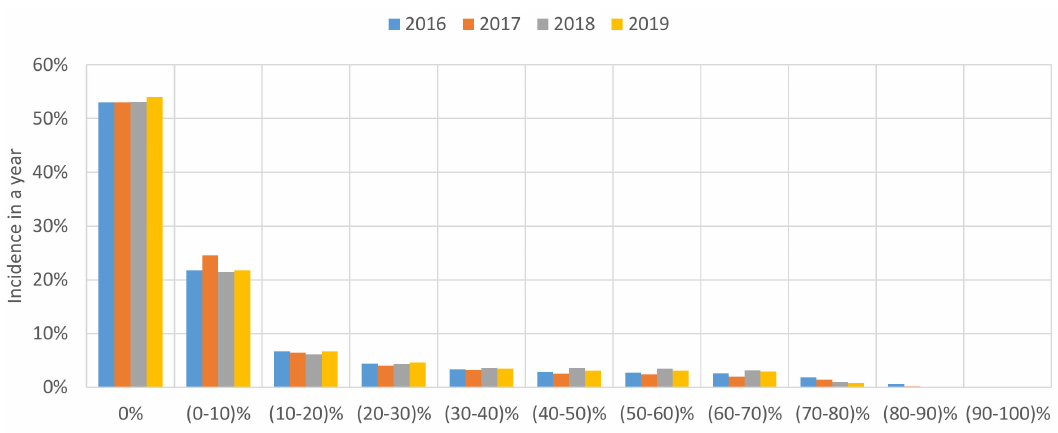
Figure 10. Percentage incidence of relative power generated for the photovoltaic power